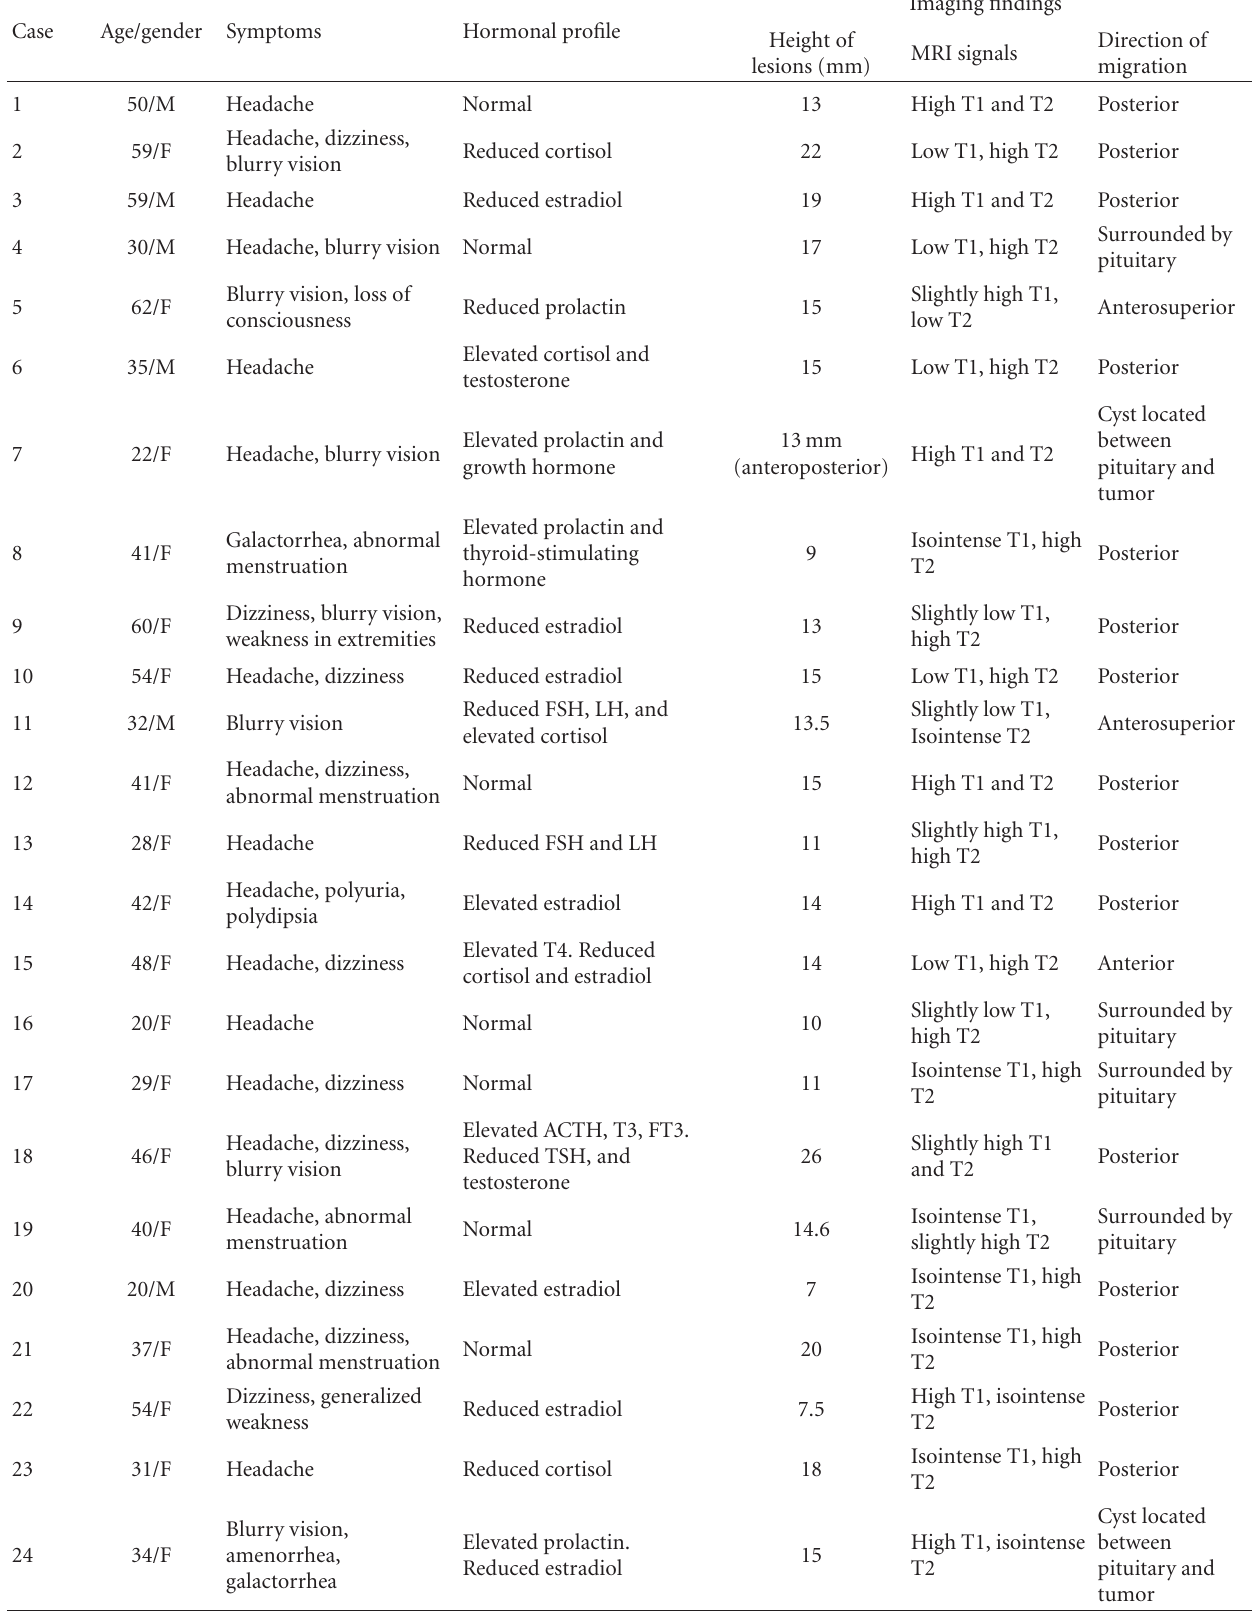
Table 1: Imaging findings for patients with Rathke’s cleft